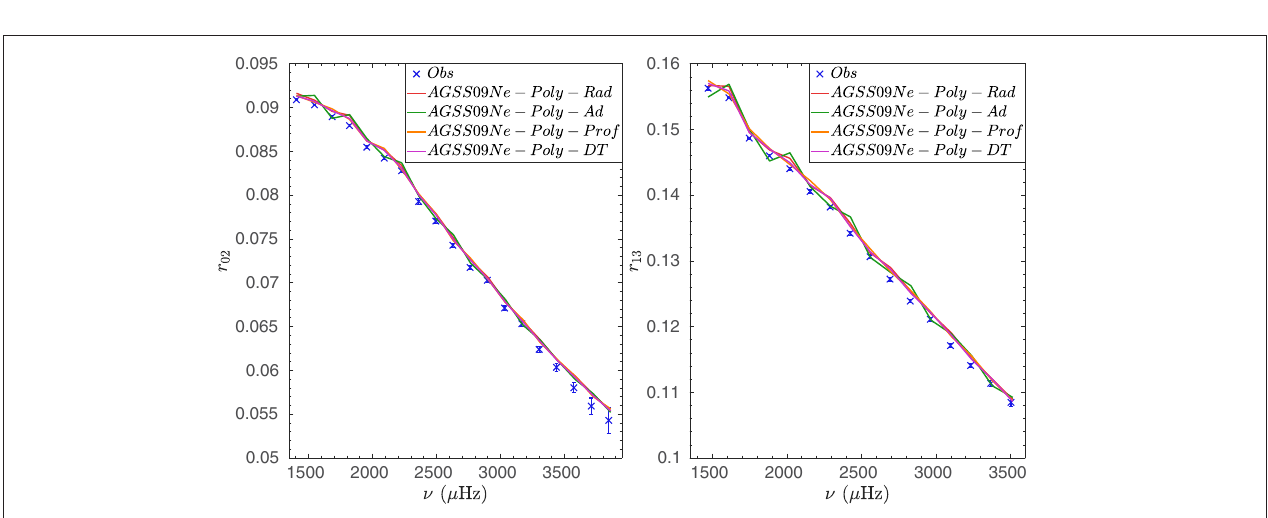
FIGURE 7 | (Upper-left) Squared adiabatic sound speed inversions for the solar models including a modified mean Rosseland opacity and additional macroscopic mixing. (Upper-right) Entropy proxy inversions for the solar models including a modified mean Rosseland opacity and additional macroscopic mixing. (Lower) Ledoux discriminant inversions for the solar models including a modified mean Rosseland opacity and additional macroscopic mixing. The error bars have the same amplitude as for the standard models but were left out to ease of readibility of the figure.